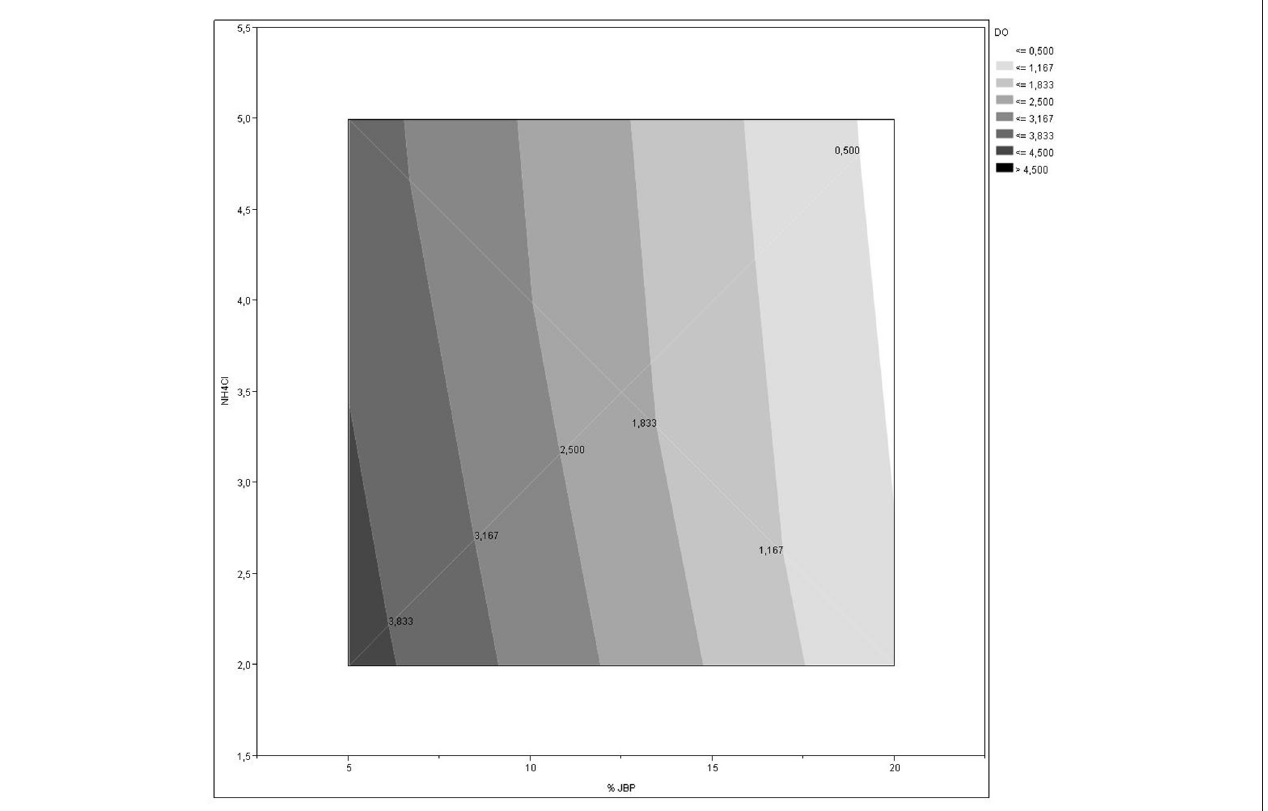
FIGURE 2 | Effect of different JBP and NH 4 Cl supplementation levels in growth medium on of C. necator cell concentration, measured as optical density at 425nm.